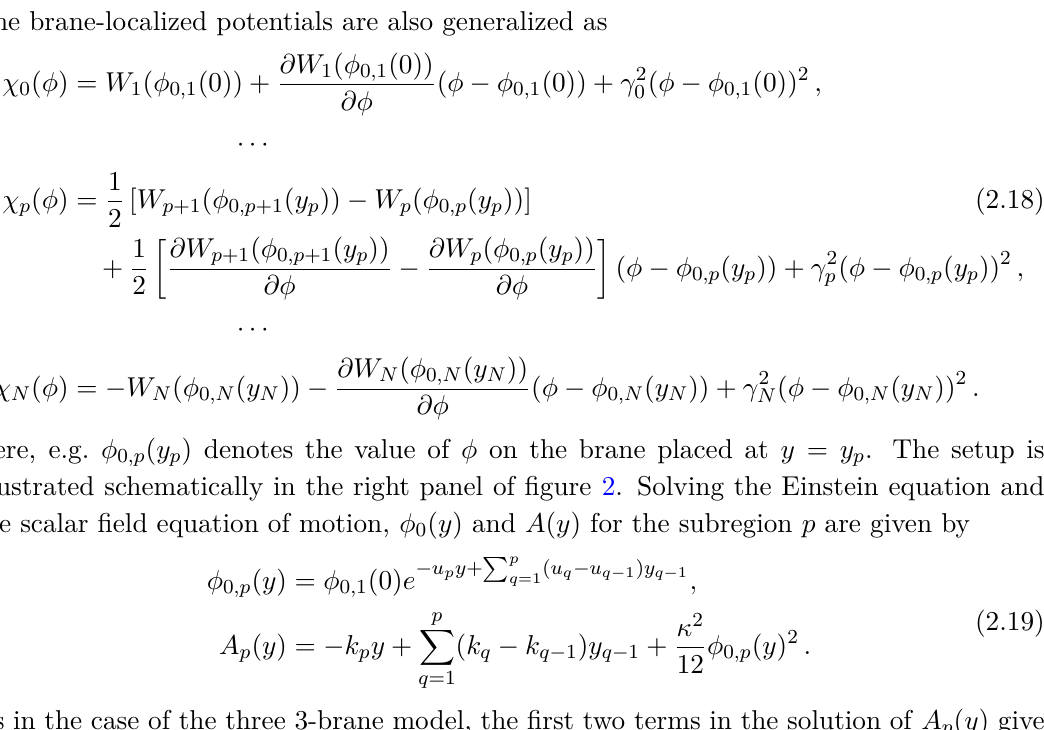
denotes the bulk p